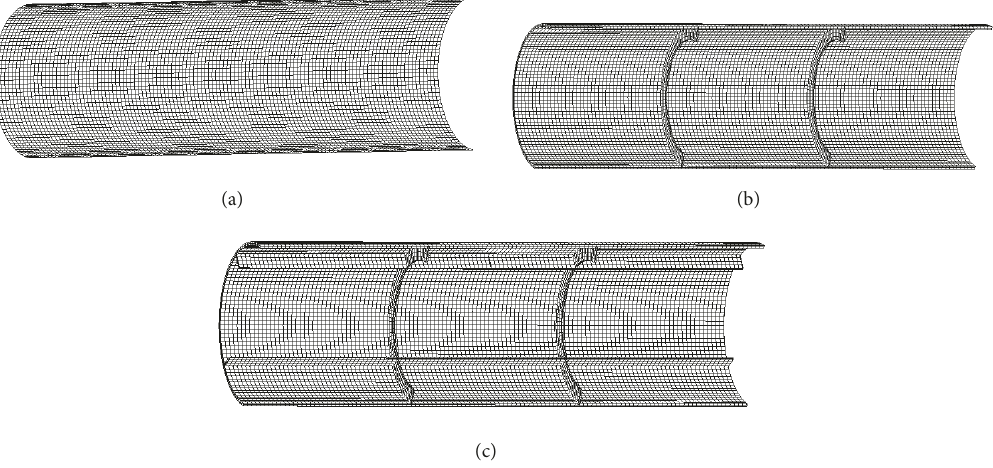
Figure 5: Cylindrical shells’ geometrical presentation: (a) simple, (b) ring-stiffened, and (c) ring-longitudinal-stiffened cylindrical shell.